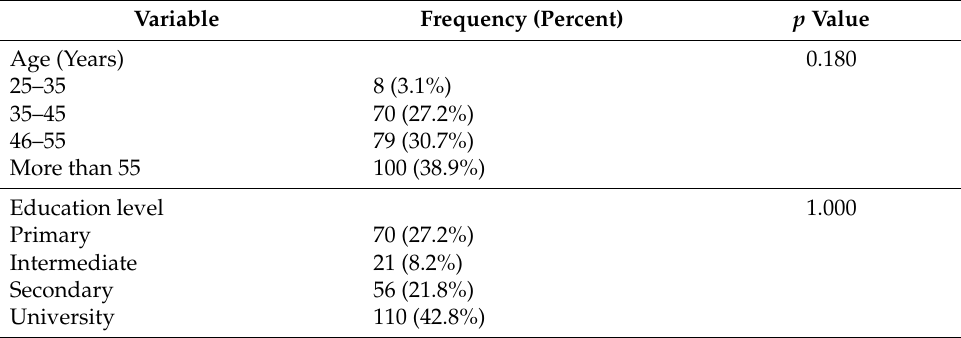
Table 1. Demographic characteristics of the study participants ( n =